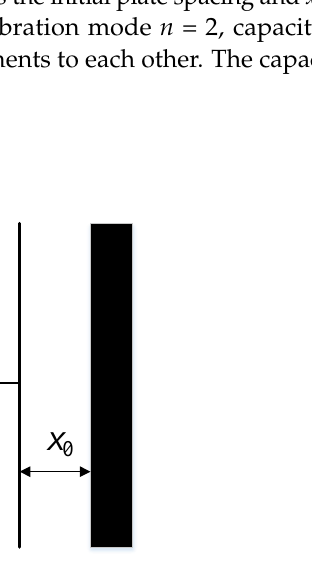
Figure 9. Model of excitation capacitance.